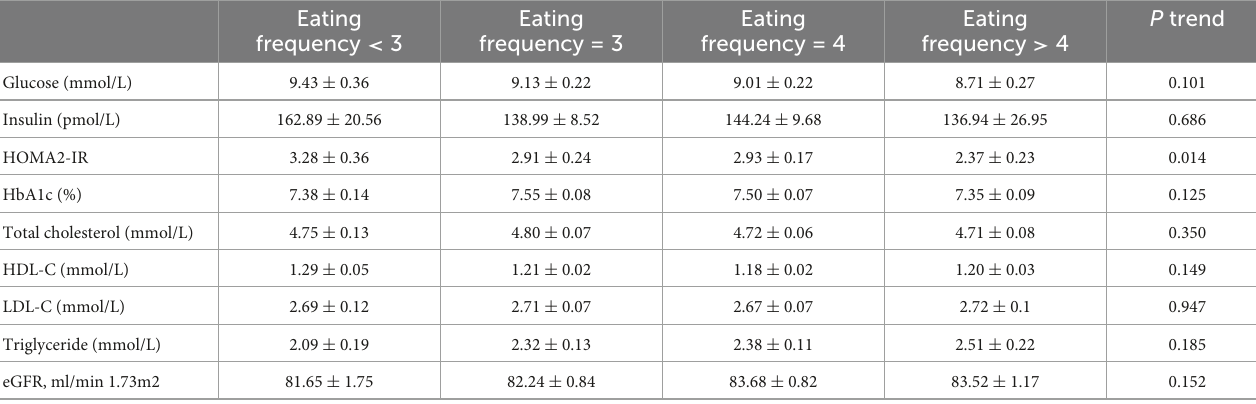
TABLE 2 Least squares mean of cardiometabolic markers according to eating frequency among diabetes.